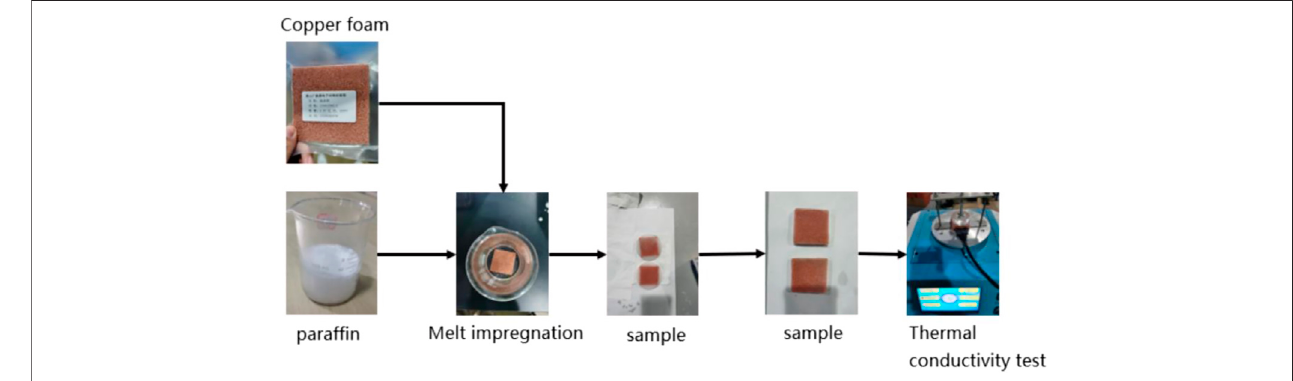
FIGURE 3 | Preparation process of copper foam/paraf fi n PCM composites.